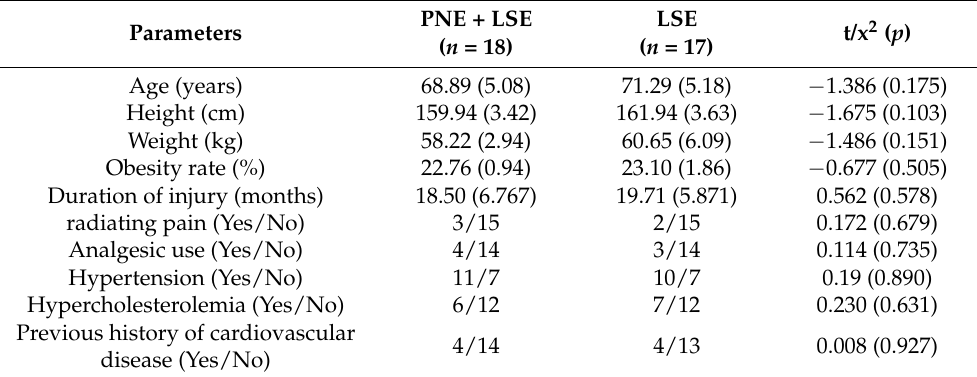
Table 3. Demographic data of the two groups ( N = 35).